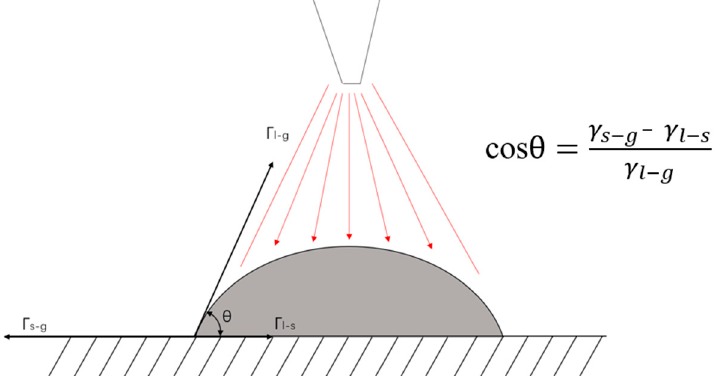
Figure 10. Schematic diagram of the relationship between the spread of the molten pool and the contact angle .